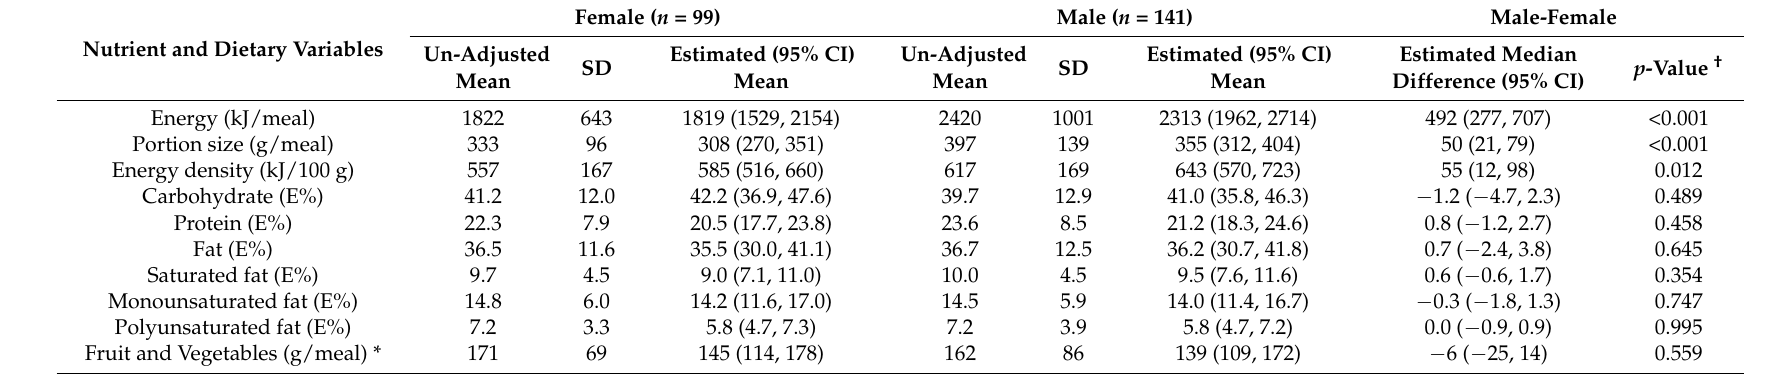
Table 4. Unadjusted and estimated mean intake according to gender and effect estimates of intake according to gender.